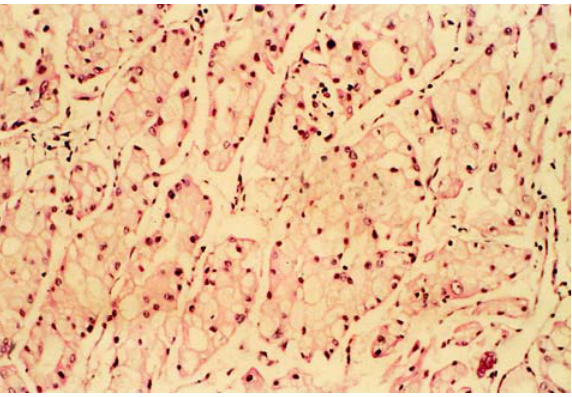
Figure 1 – Undifferentiated nasopharyngeal carcinoma, WHO type III (HE,